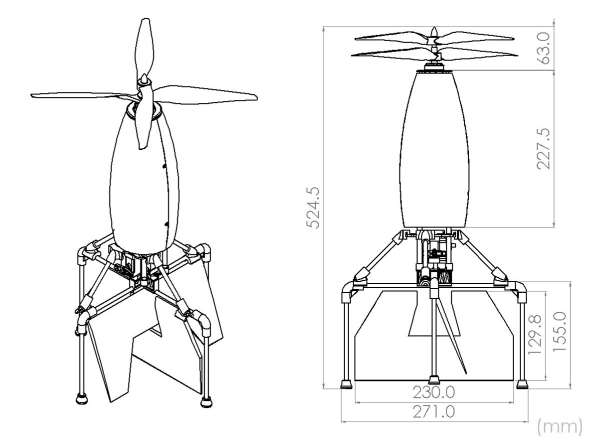
Figure 3. MCR UAV v3.0 dimensions. Table 1. Avionics used in MCR UAV v3.0.